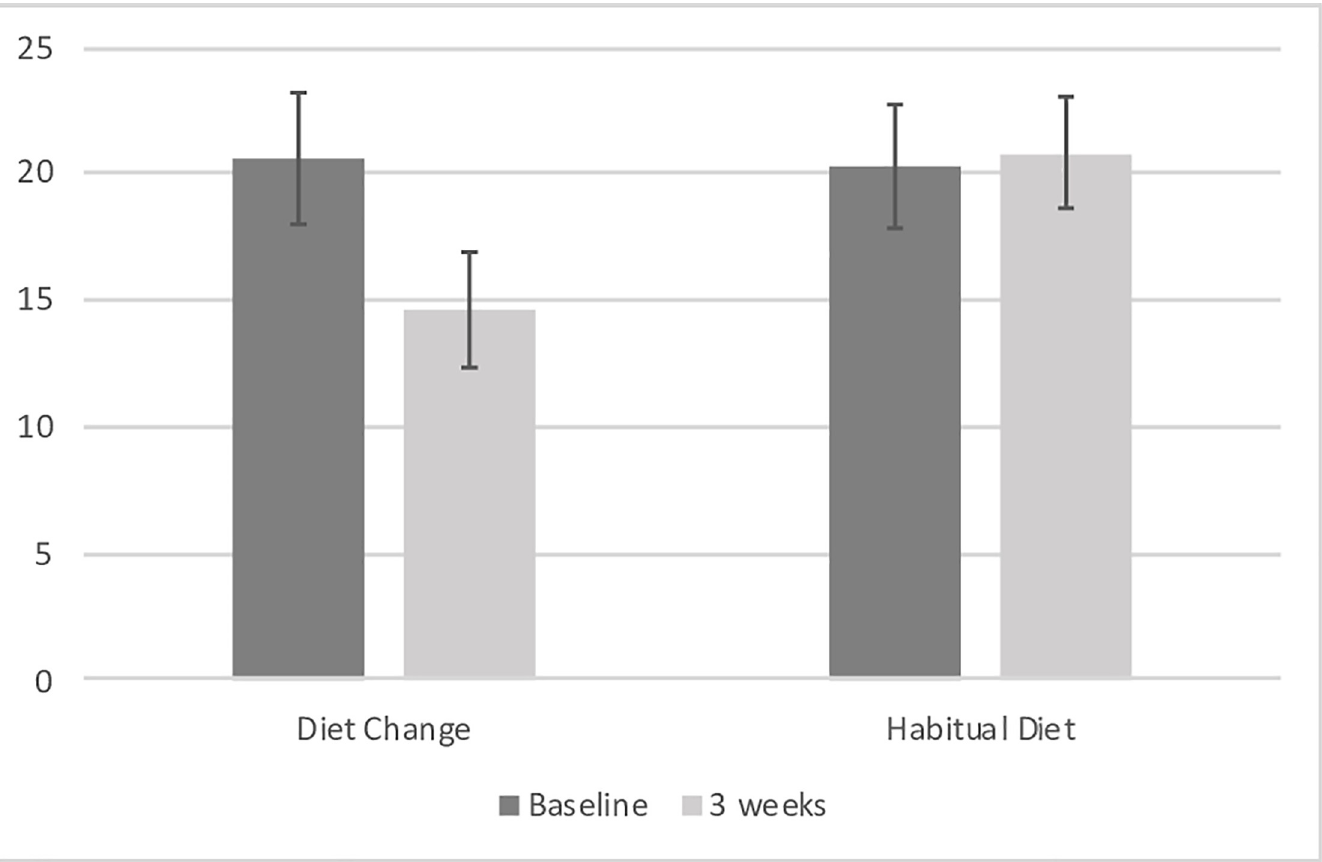
Fig 2. Center for Epidemiological Studies Depression scale—Revised scores for diet change (n = 38) group were significantly lower than the habitual diet (n = 38) group following 3 weeks of diet improvement, controlling for baseline scores (effect size: Cohen’s d = 0.65).